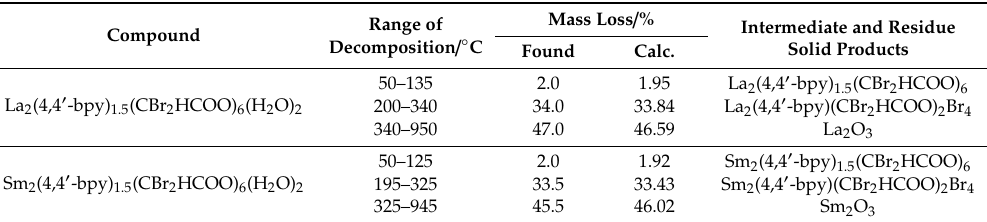
Table 1. Thermal decomposition data of La(III) and Sm(III) compounds. Range of Compound Decomposition / ◦